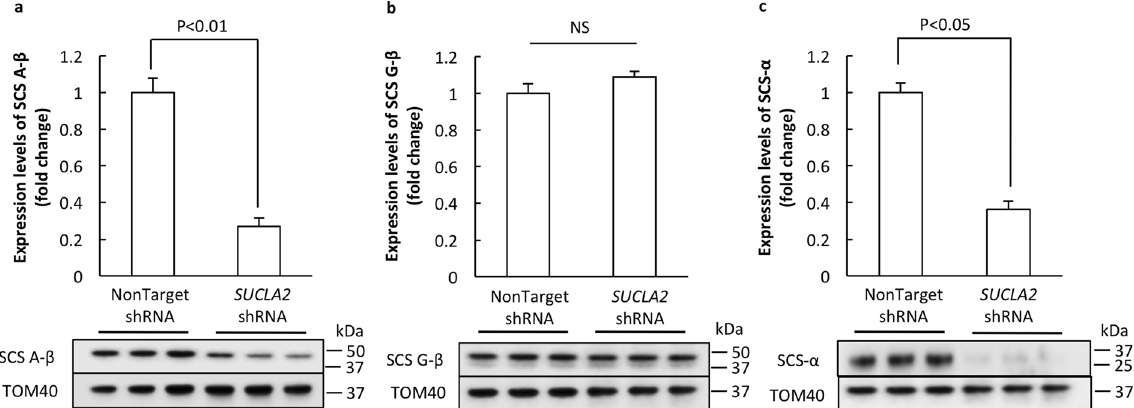
Figure 1. Down-regulation of SCS A- β inhibits SCS- α expression. SUCLA2- shRNA treated neurons demonstrated a significant decrease in SCS A- β expression levels ( a ); while SCS G- β expression was not affected ( b ). The expression levels of SCS- α were decreased accompanying SCS A- β loss ( c ). The lower panels are representative immunoblots. TOM40 was used as the loading control. The data were collected from 3 independent experiments.